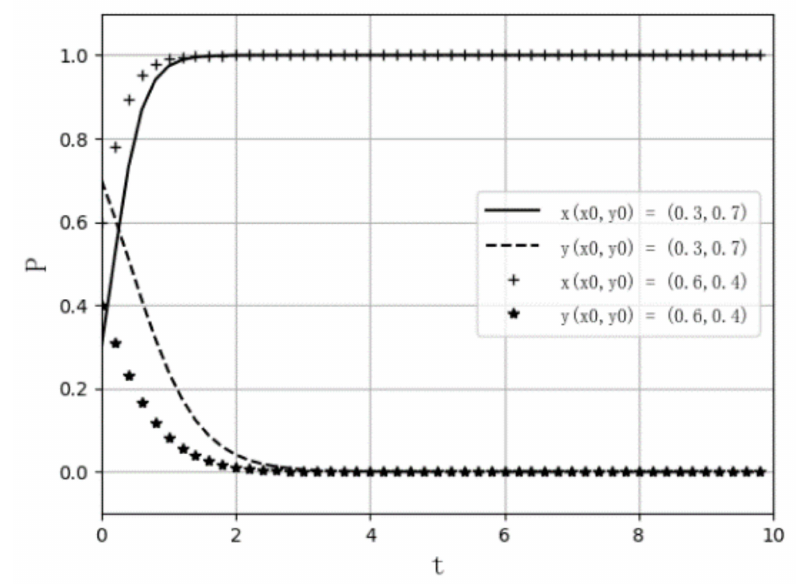
Figure 5. Path diagram of the evolutionary game on abandoned land transfer between farmers and agricultural enterprises under constraints ( I 2 + B > I 3 − C and I 2 + F + T 2 < I 1 + T 1